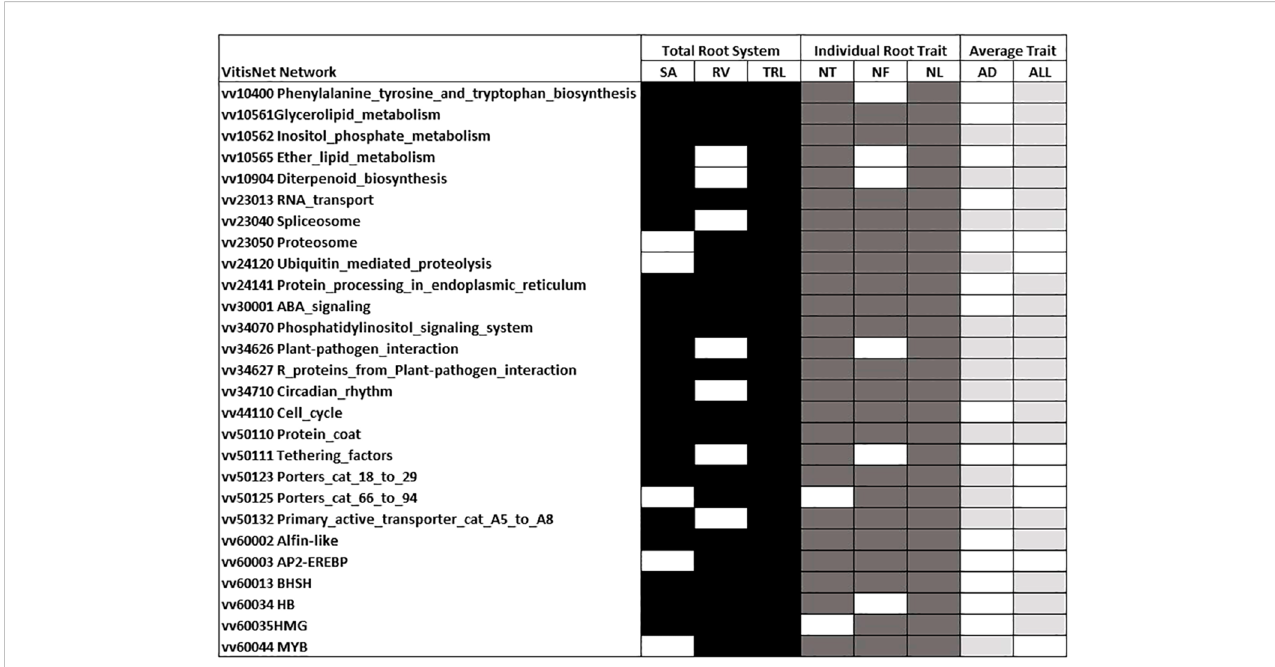
FIGURE 7 Enriched VitisNet pathways for modeled total root system, individual root and average traits. Shading indicates the signi fi cantly enriched pathway for total root system (black), individual root (dark gray), and average root (light gray/) traits (Fisher test p-value 0.05) White indicates not enriched. Only pathways enriched in at least fi ve of the modeled traits are presented. All enriched pathways for an individual modeled trait are in Supplementary Table 2. Trait abbreviations are noted in Table